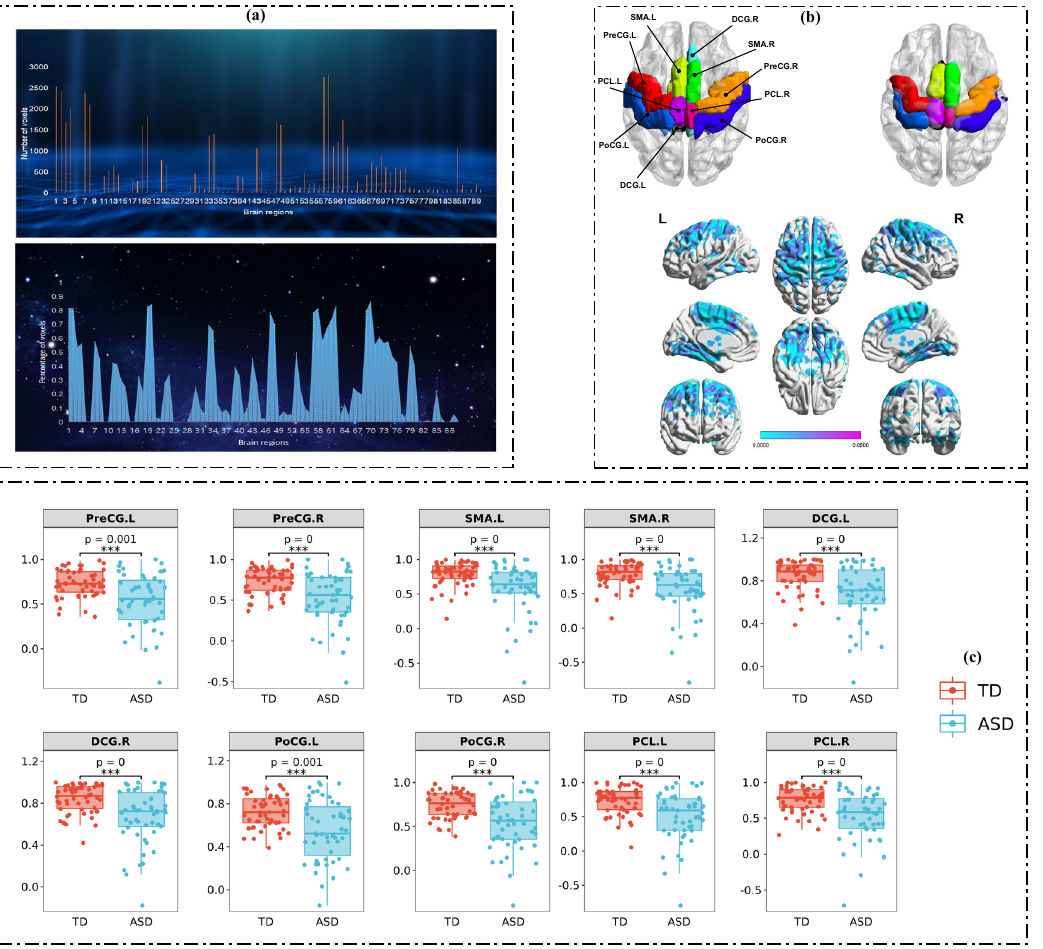
Figure 2. Statistical results of group differences analysis between ASD and TD: ( a ) The statistical results of those voxels with significant group differences. ( b ) The brain mapping results of those voxels with significant group differences. ( c ) The boxplot visualization results of the 10 brain regions with the largest differences.